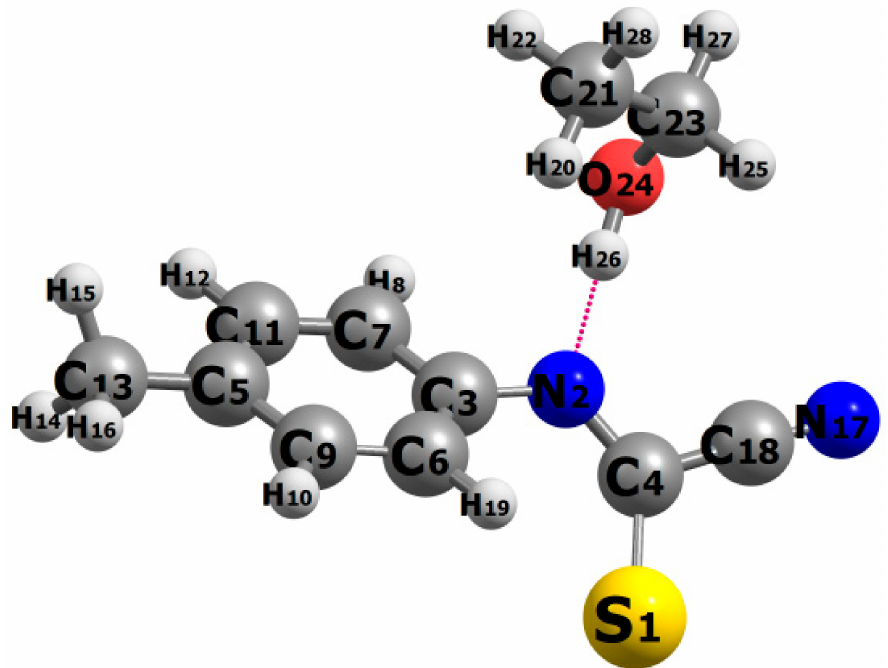
Figure 11. Relaxed structure of the hydrogen-bonded complex between deprotonated 27 (with R = CH 3 ) at the bottom with an explicit ethanol molecule above. The violet dashes between H26 and N2 atoms indicate the intermolecular hydrogen bond. Color code for atoms: grey = C, blue = N, red = O, yellow = S, and white =